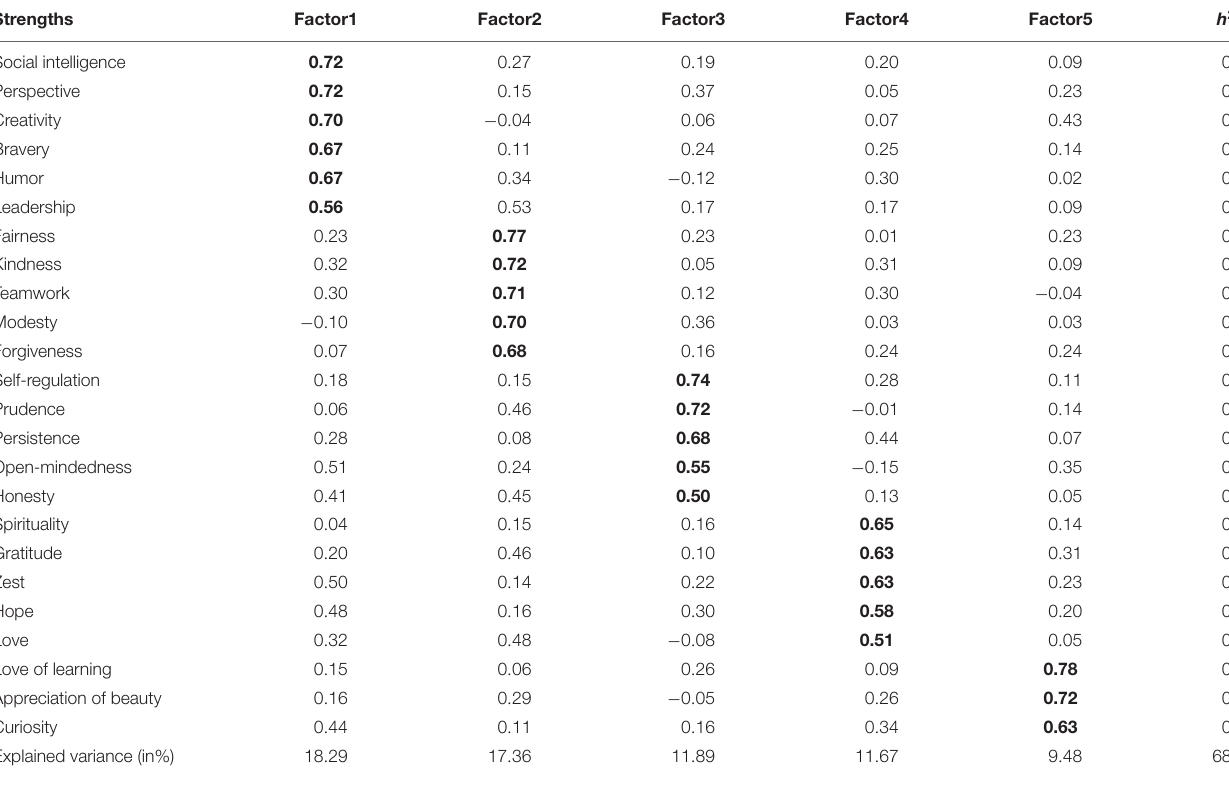
TABLE 2 | Five-factor solution for the